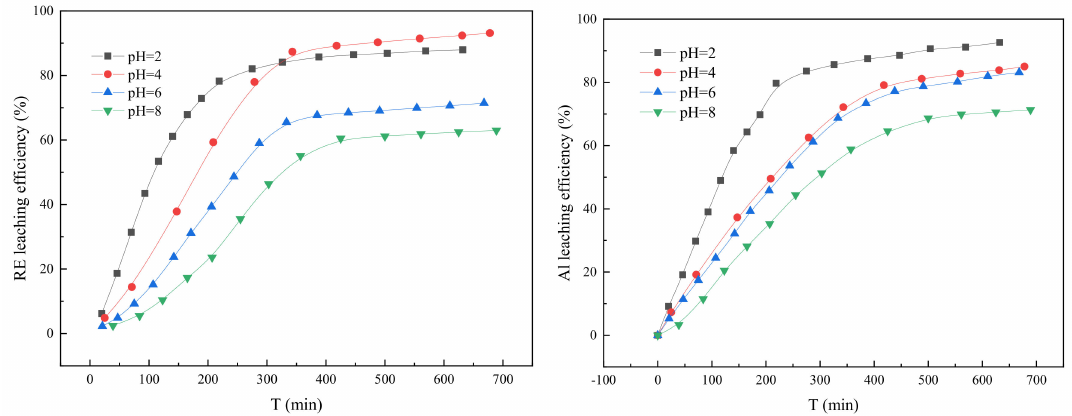
Figure 14. E ff ects of pH on the leaching rates of RE and